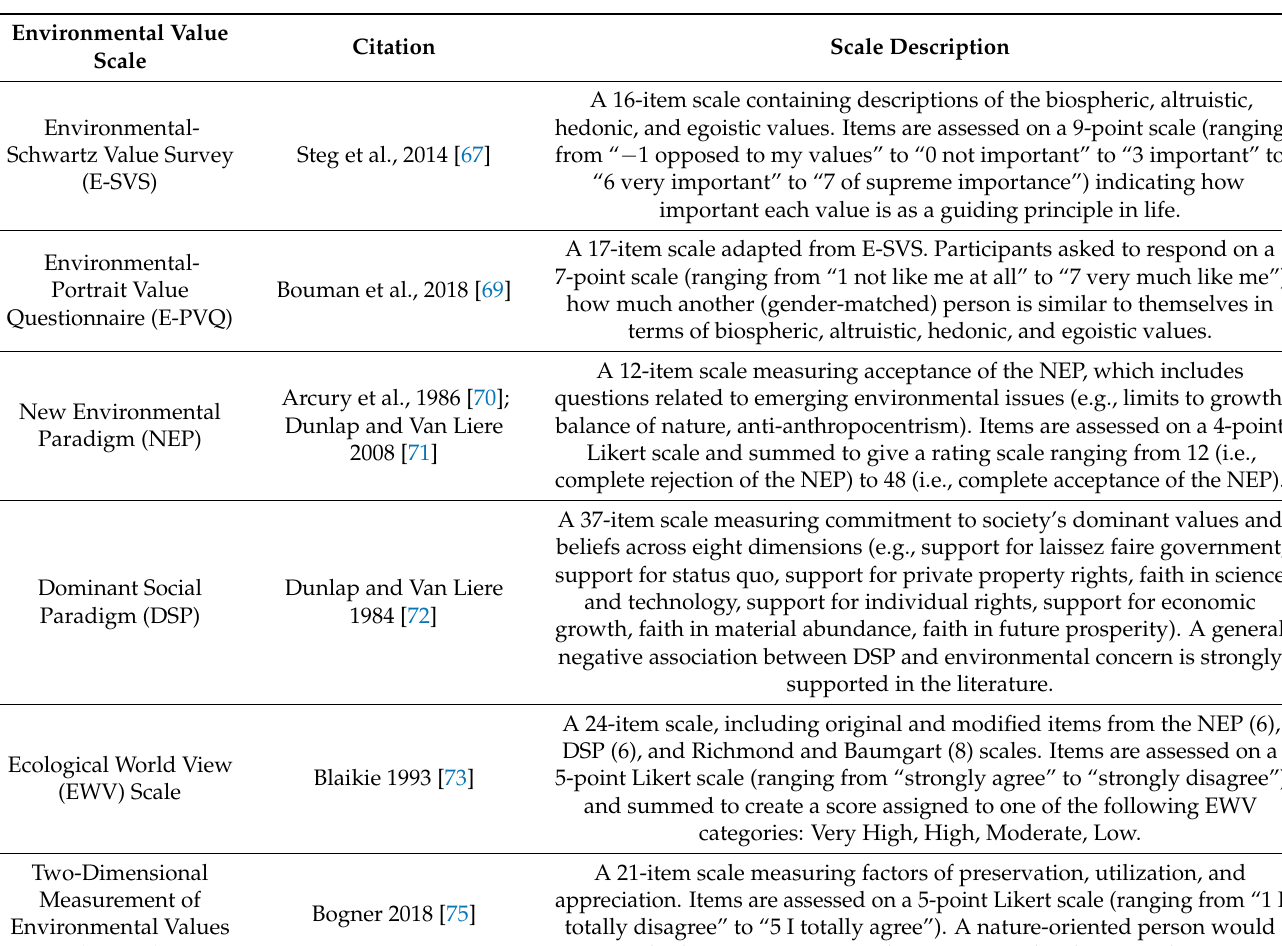
Table 2. Brief descriptions of selected environmental value